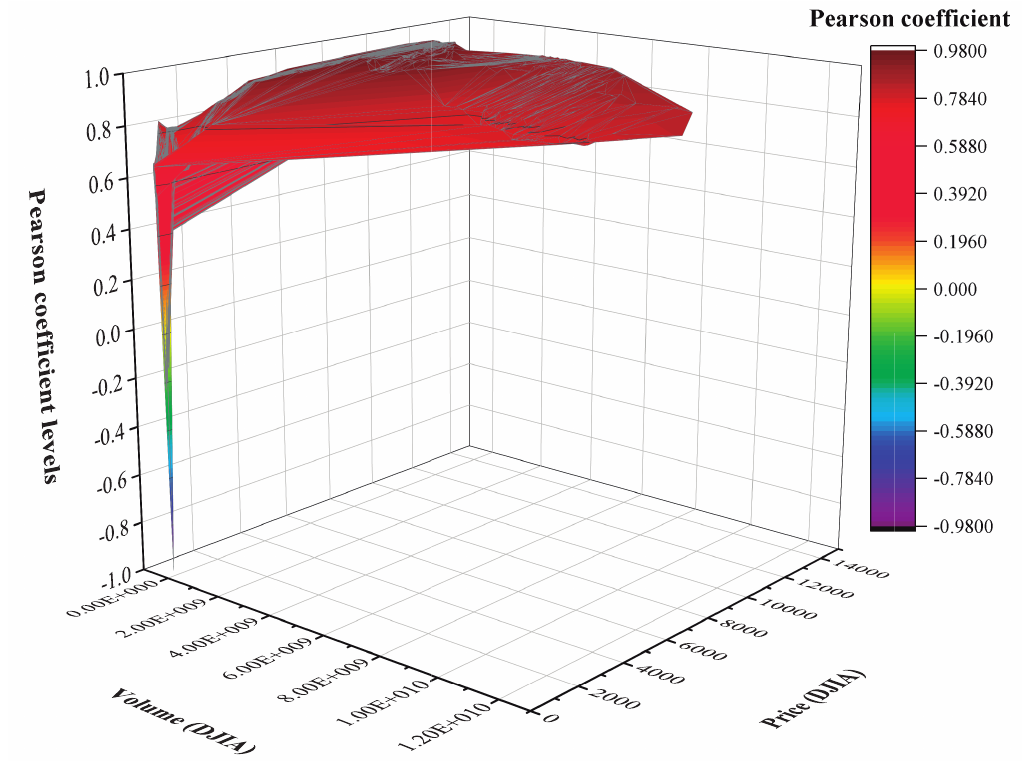
Figure 2. Scatter plot of ρ vs. Price (DJIA)-Volume (DJIA). Source: Own